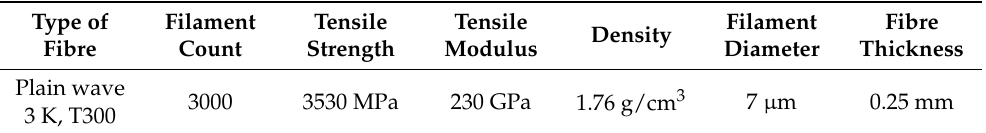
Table 1. Prominent properties of carbon fibre